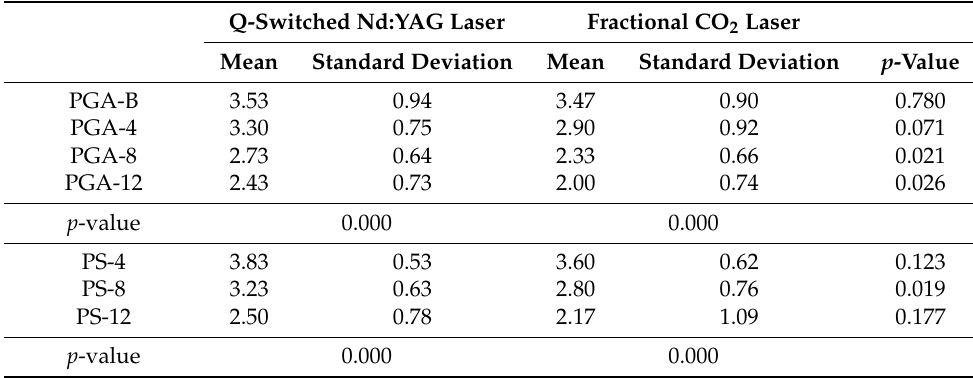
Table 2. Mean and standard deviation of PGA and PS in both groups over